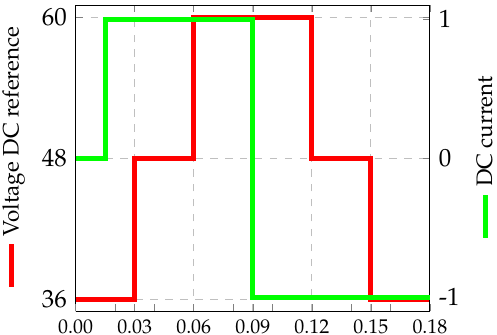
Figure 7. Different voltage DC